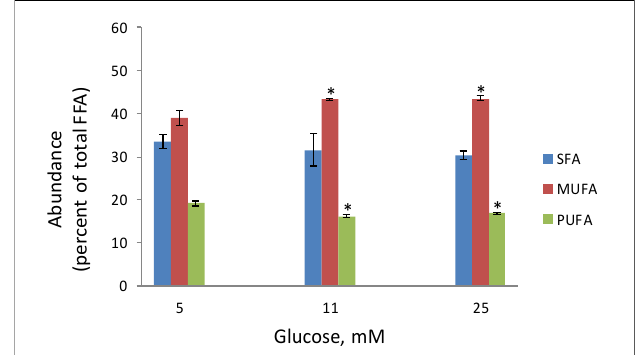
Figure 1. Glucose-induced remodeling of phospholipid in INS-1E cells. INS-1E cells were incubated in serum-free medium supplemented with the indicated glucose concentration for 16 h, and processed for lipidomics analysis as described [13]. The abundance of Saturated- (SFA), Monounsaturated- (MUFA) and polyunsaturated fatty acids (PUFA) is given as percent of total fatty acid content. Mean ± SEM, n = 4. * p < 0.05 significantly different from the corresponding abundance at the 5 mM glucose incubation (adapted from [13]).